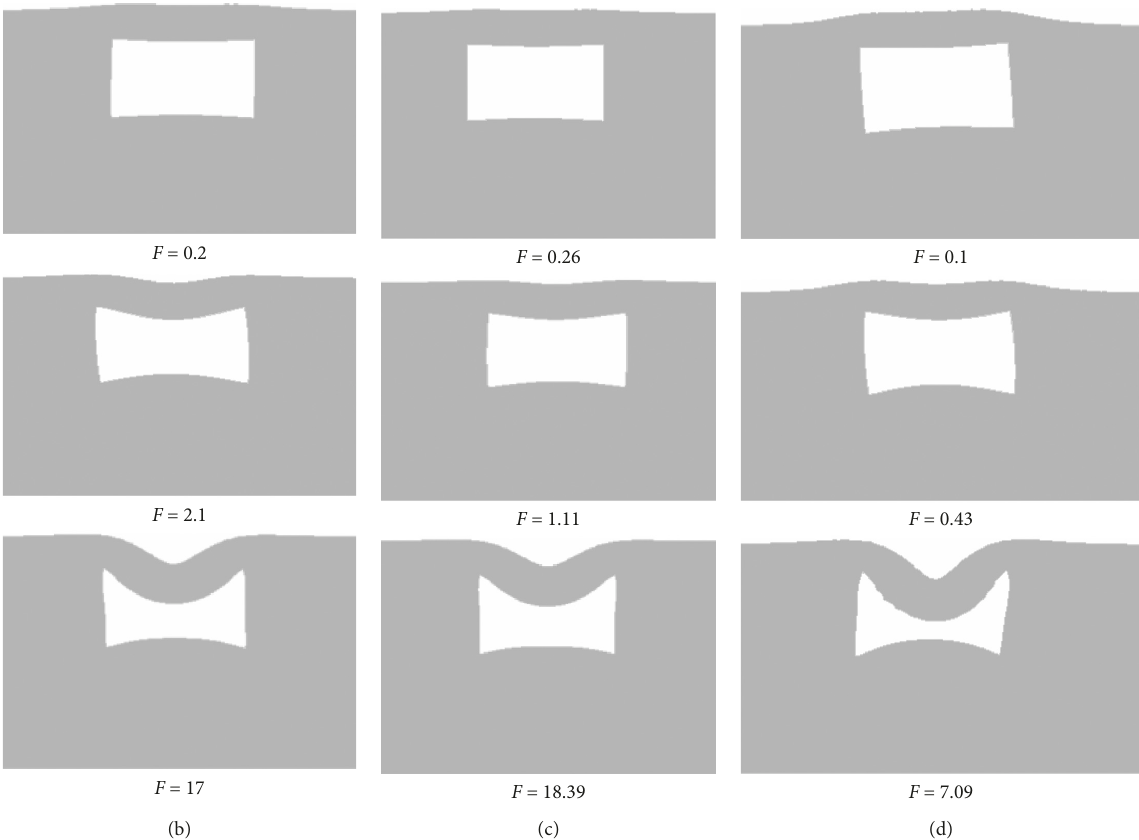
Figure 18: (a) Undeformed shape. Deformed shapes (scale factor � 50 magnification) plotted at time step of maximum thrust for (b) Loma Prieta, (c) Nahanni, and (d) Chi-Chi